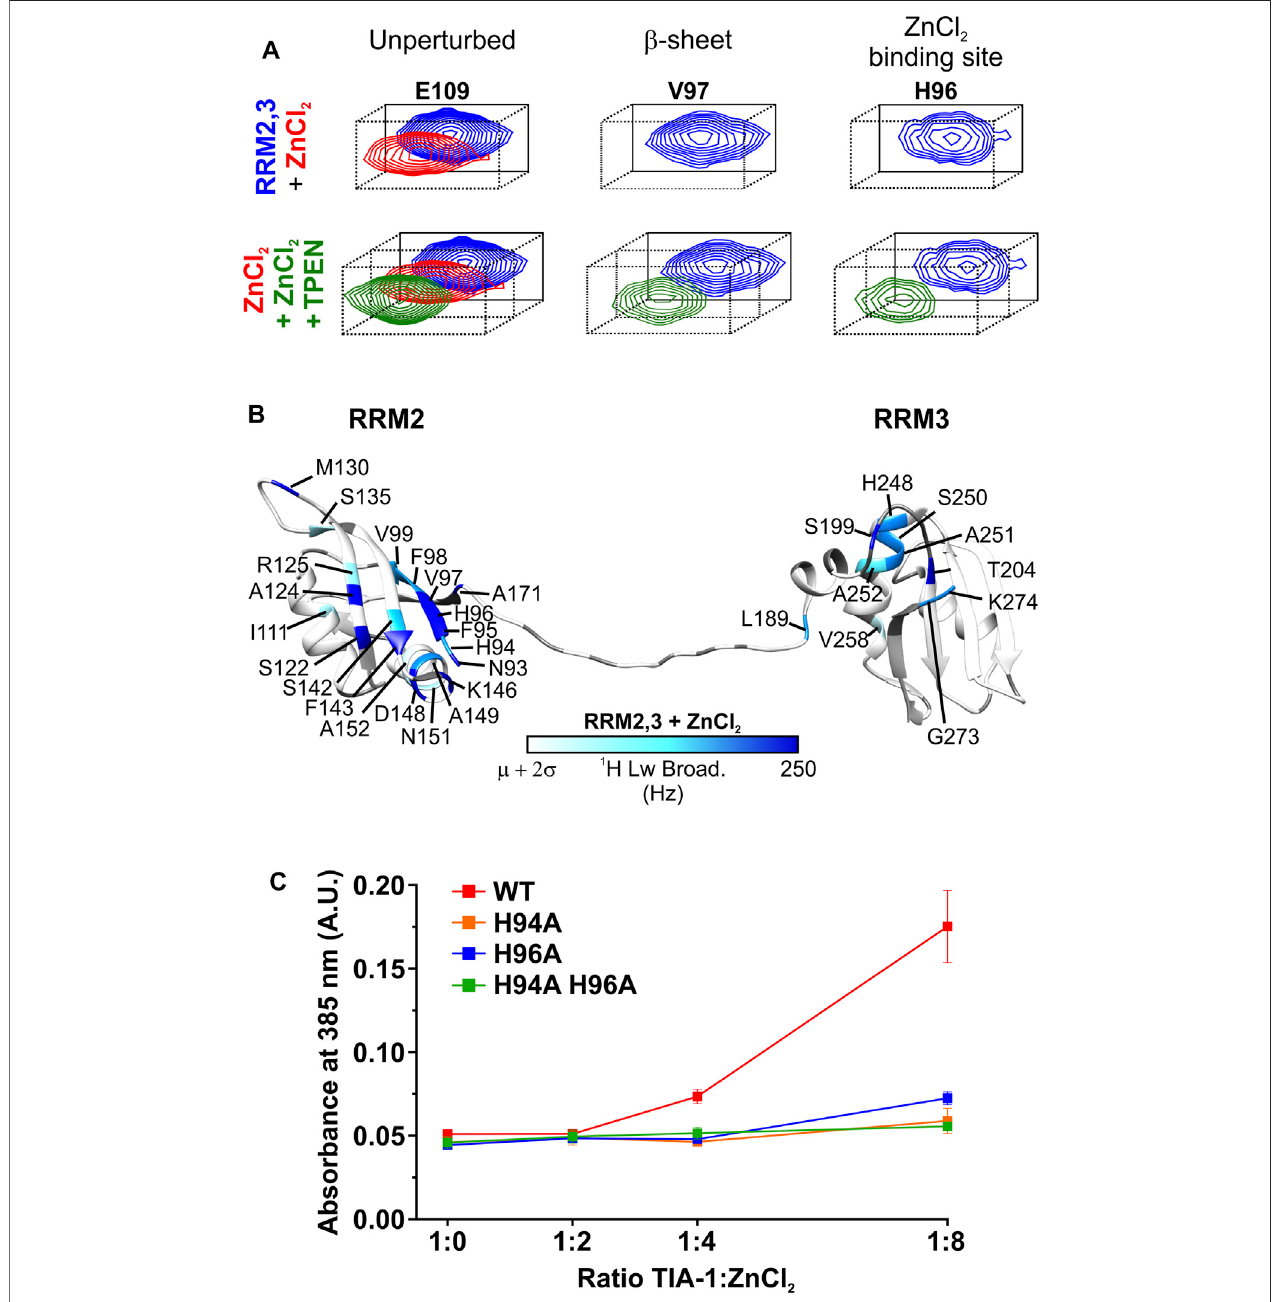
FIGURE 2 | Zn2+ speci fi cally binds to TIA-1 RRM2,3 and mediates protein multimerization. (A) Detailed view of representative amide resonances of unperturbed ( left panel ), ß -sheet ( middle panel ) or Zn 2+ binding site ( left panel ) TIA-1 RRM2,3 residues from the superimposed [ 1 H- 15 N] HSQC spectra of 15 N-labeled TIA-1 RRM2,3 construct either free ( blue ) or upon incubation with ZnCl 2 ( red ) or ZnCl 2 + TPEN ( dark green ). Whole views of 2D NMR spectra are included in Supplementary Figures S2A,E . (B) Map of 1 H-linewidths on the TIA-1 RRM2,3 ribbon upon addition of an equimolar ratio of ZnCl 2 . Residues with 1 H line broadening larger than the average ( µ ) plus two standard deviations ( σ ) are colored using a white-to-blue scale. Prolines and unassigned residues are colored in grey. TIA-1 PDB ID: 2MJN (Wanget al.,2014).Conditions:20 mMHEPES, 50 mMNaCl, 5 mMTCEP, pH6.9,at25 ° Candupon30 minincubationwithZnCl 2 orZnCl 2 +TPEN. (C) Comparisonof turbidity (A 385 nm ) produced by TIA-1 RRM2,3 WT and different His-to-Ala mutants at increasing concentrations of ZnCl 2 . All measurements were performed by using TIA-1 constructs at 20 µM concentration. Conditions: 20 mM HEPES, 50 mM NaCl, 1 mM TCEP, pH 6.9, at 25 ° C and within 30 min incubation under shaking. 3 replicates. Error bars represent